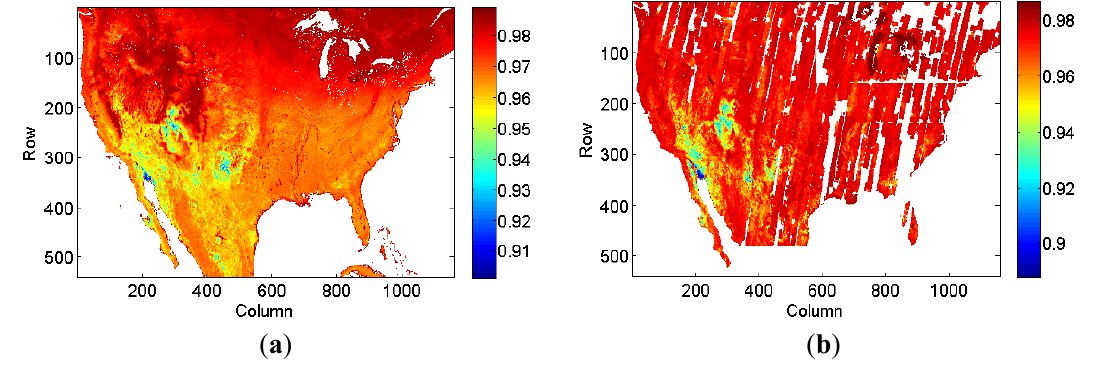
Figure 2. Comparison between NAALSED BBE and GLASS BBE for winter season. ( a ) GLASS BBE; ( b ) NAALSED BBE; ( c ) the difference between GLASS BBE and NAALSED BBE; ( d ) the histogram of the